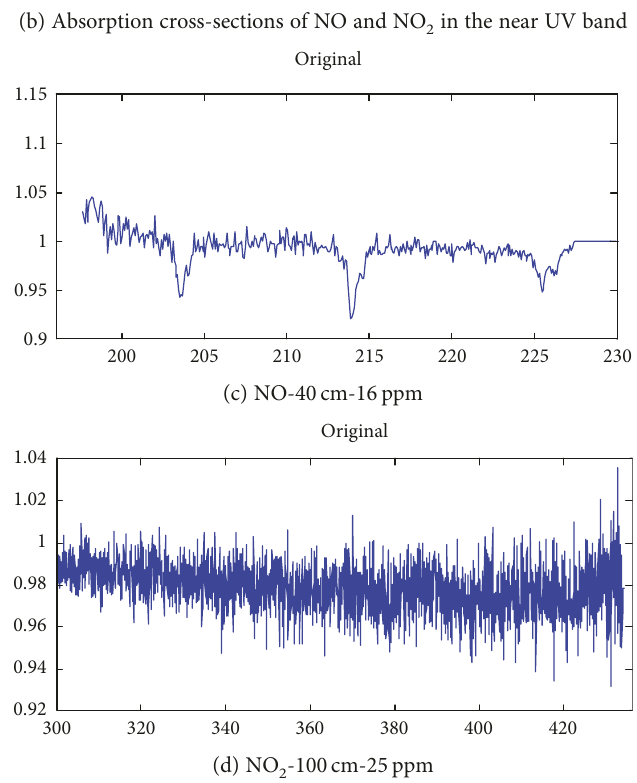
Figure 2: Transmission spectra of NO and NO